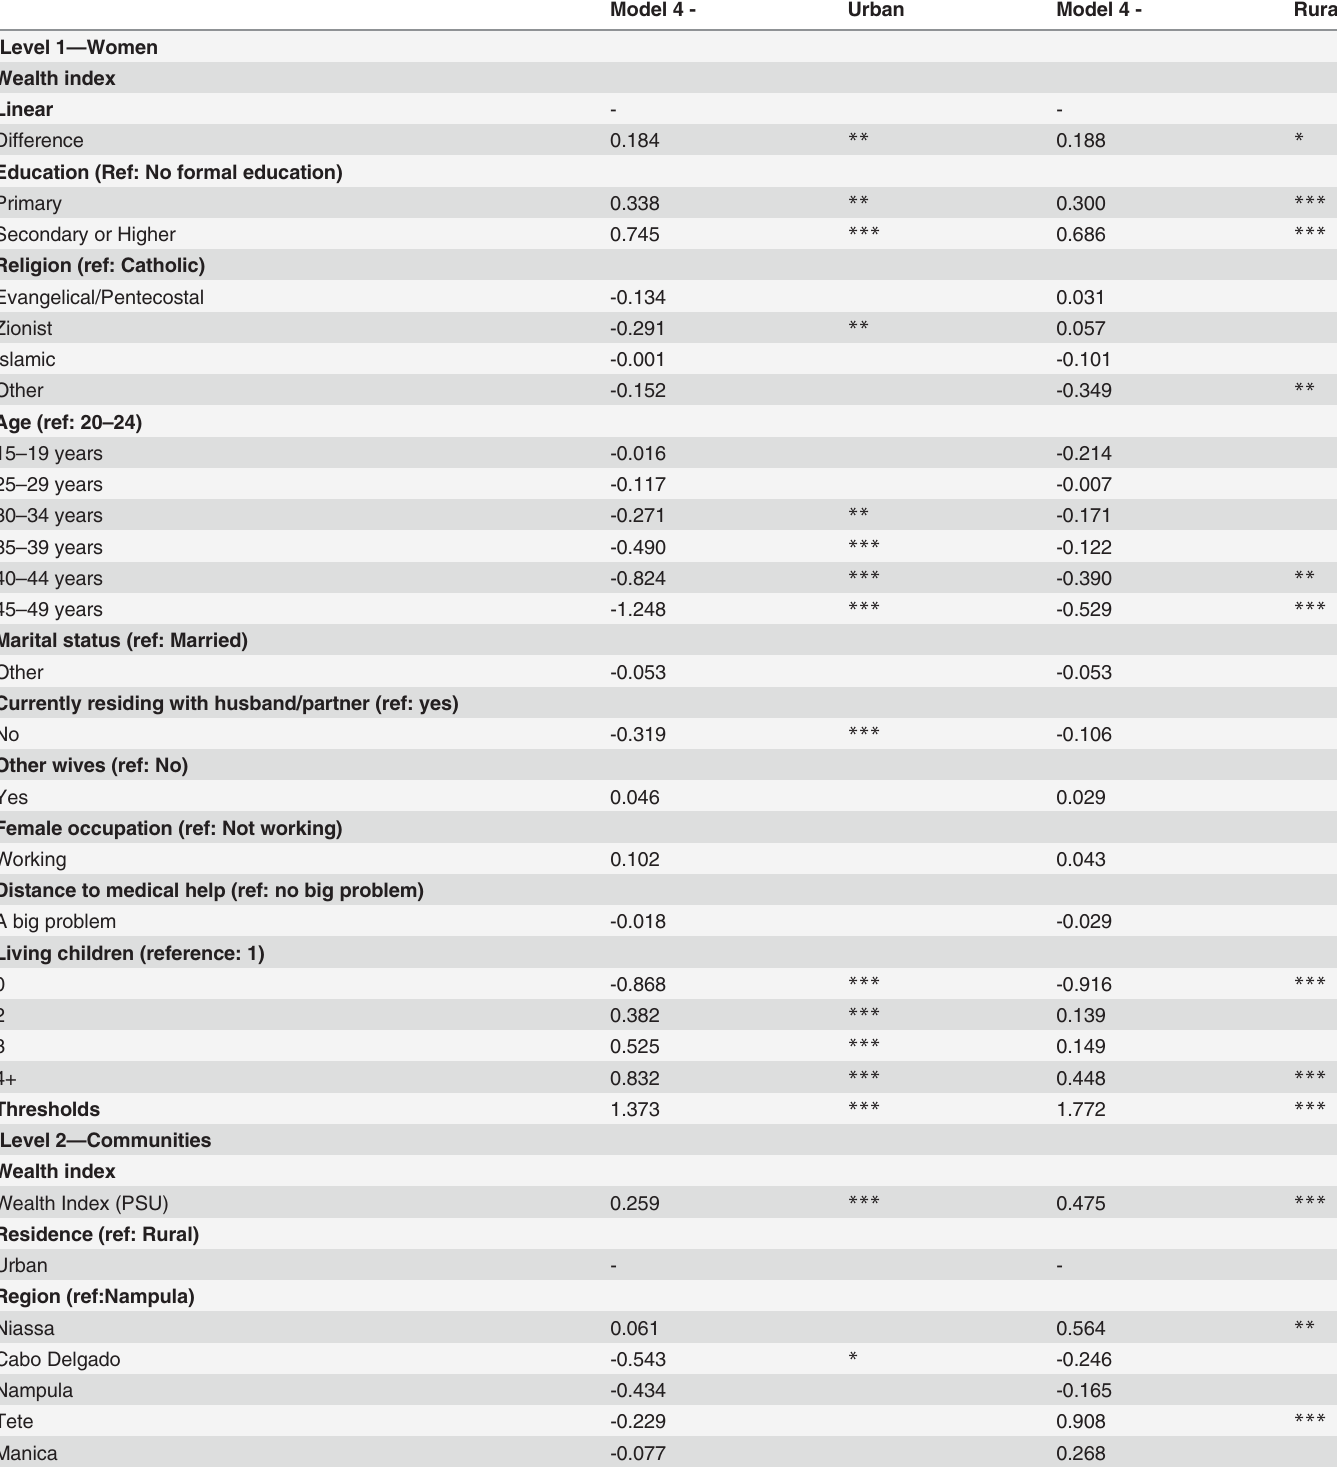
Table 3. Probit regression models for contraceptive use in urban and rural areas (ref: